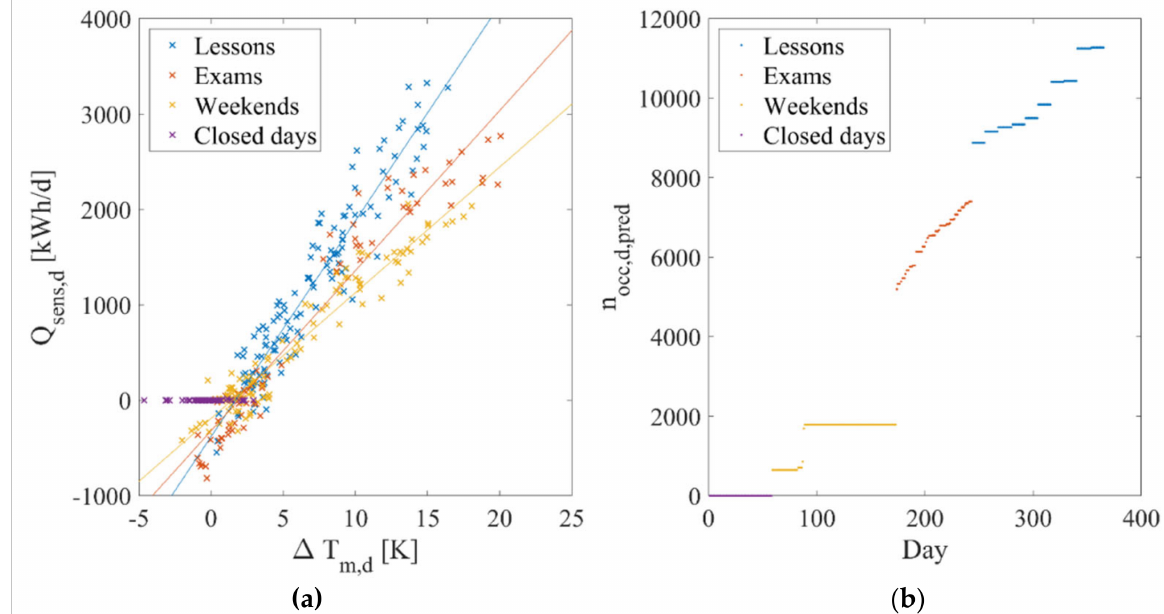
Figure 6. Correlation between daily sensible energy demand and the difference between indoor and outdoor temperature ( a ); predicted daily number of occupants for different clusters ( b